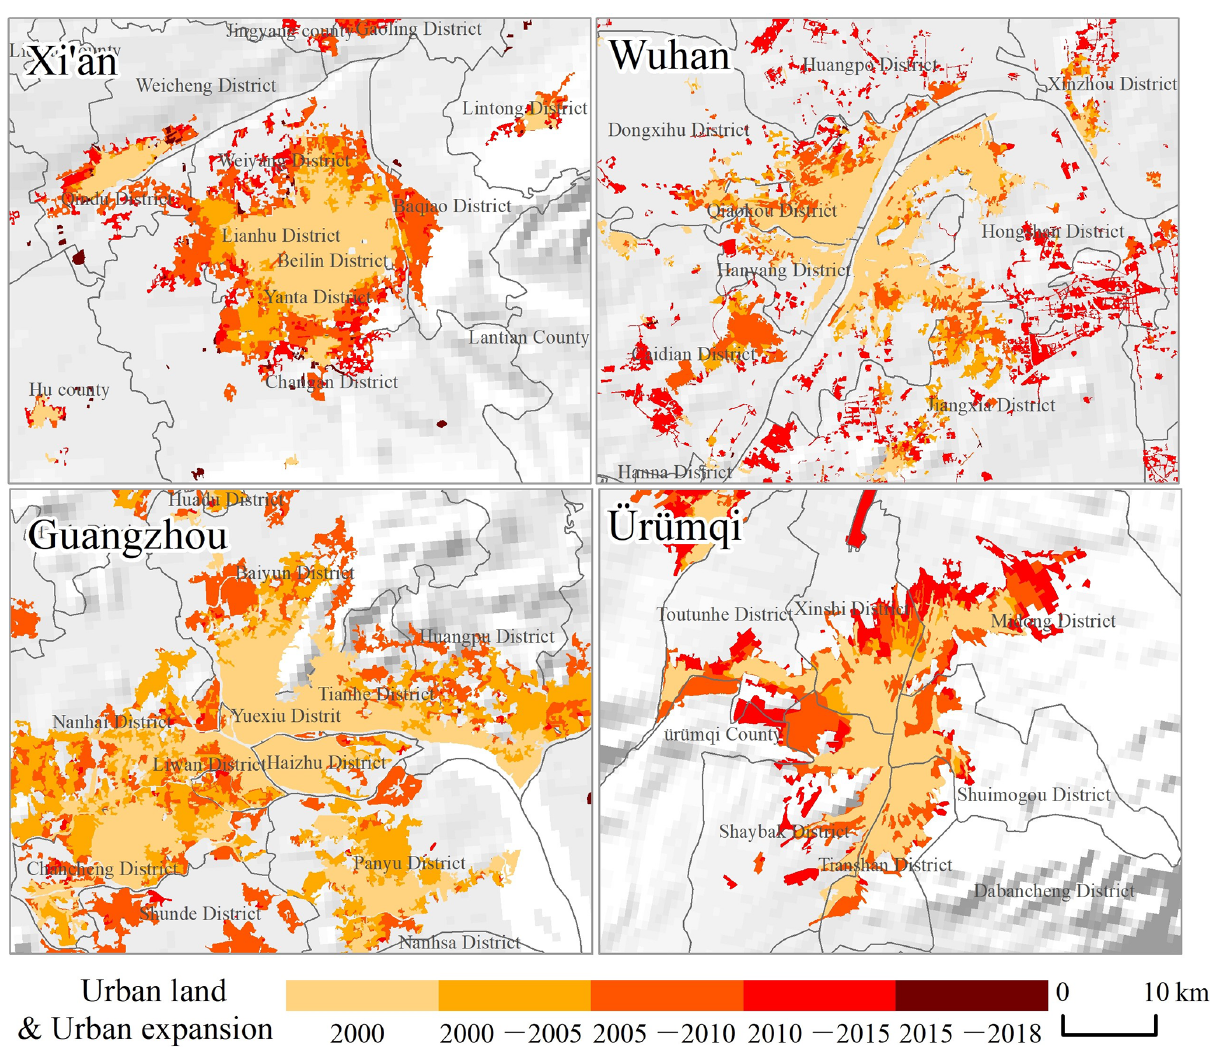
Figure 4. The urban boundaries extracted from CLUD with a 30m resolution in selected cities. The administrative boundaries were provided by the National Geomatics Center of China (http://www.webmap.cn, last access: 15 September 2020); DEM dataset was downloaded from SRTM 90m digital elevation data (http://srtm.csi.cgiar.org/, last access: 15 September